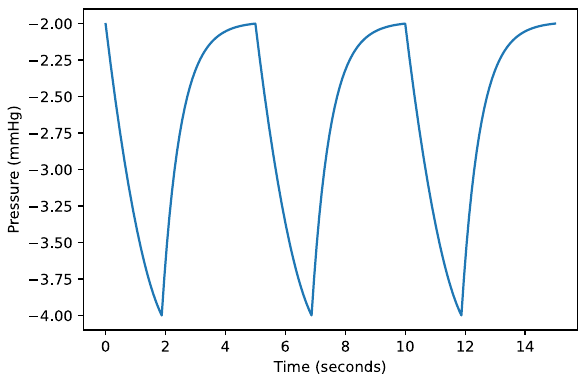
Fig. 6 Ventilation. Simulated intra-thoracic pressure curve with a respiratory rate of